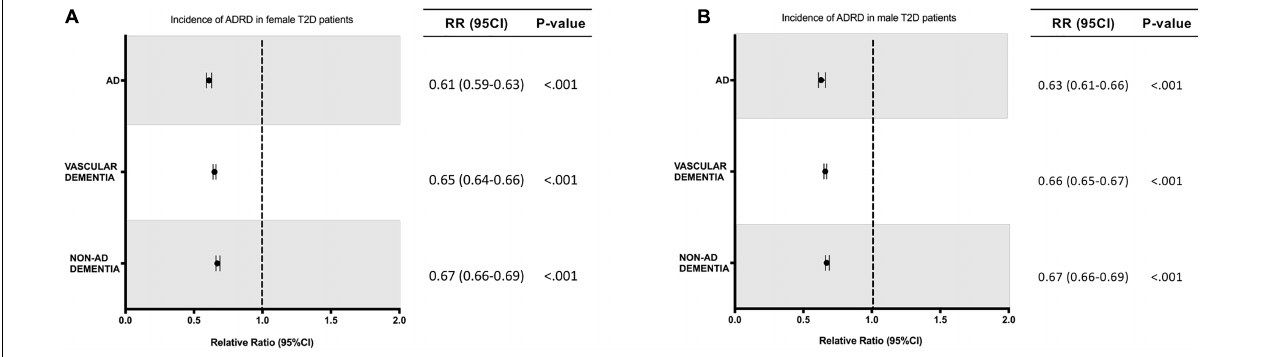
number of patients needed to treat to reduce risk of AD, VasD, and non-AD dementia was 95.32, 274.9 and 55.26 respectively in the adjusted population ( Table 6 ). Additional analyses indicated no significant sex differences in AD and